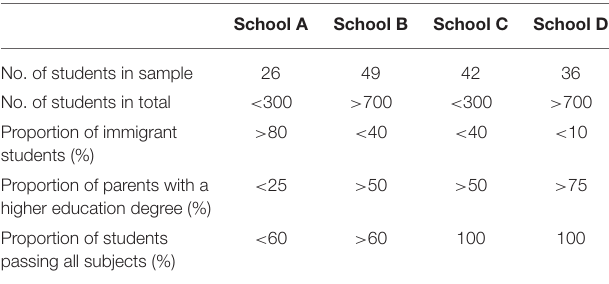
TABLE 1 | Number of students from each school in the sample, as well as school